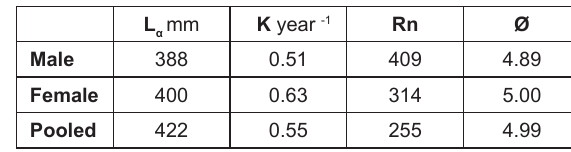
Table 1. Growth parameters in male, female and pooled population of H. brachysoma of Periyar River